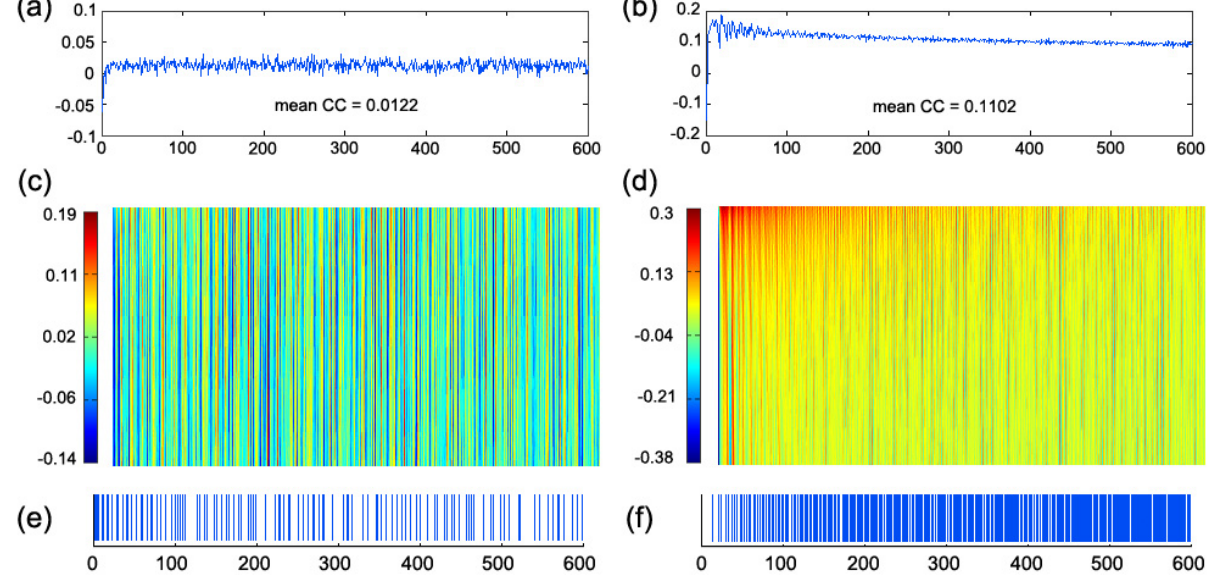
Figure 10: (a) The spacing between neighbouring zeta zeros 10 2 − 10 4 is compared with a GUE distribution 32 π − 2 s 2 e − 4 s 2 /π (red), showing coincidence of the two statistics, and a GOE 1 π se − π s 2 (green) characteristic of the Wigner distribution of atomic 2 nuclear energies. The relationship is short range only and deviates for larger spacings [20] such as 100 apart (c). (b) Pair correlations for the first 10 5 neighbouring zeros compared with the theoretical GUE distribution. (c) Berry’s predictions using semi-classical analysis (dashed line) of longer-range deviations of the zeta zeros from the GUE were confirmed numerically (black circles) using Odlyzko’s numerical calculations.